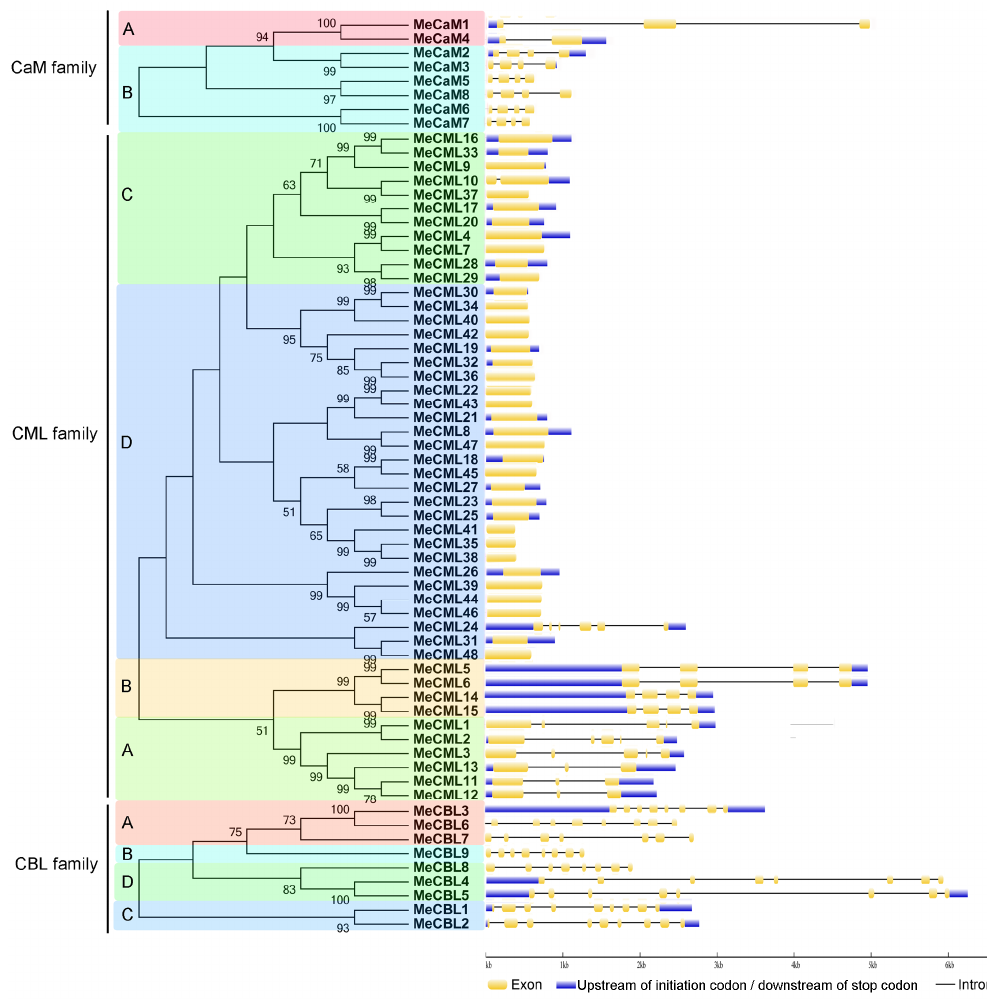
Figure 3. Gene structure analyses of cassava CaMs, CMLs, and CBLs according to phylogenetic relationship. Exon-intron structure analyses were performed through the gene structure display server database. The blue boxes, yellow boxes, and black lines indicate upstream of initiation codon/downstream of stop codon, exons, and introns, respectively. Shade areas with different colors indicate distinct groups of CaM, CML, and CBL families.